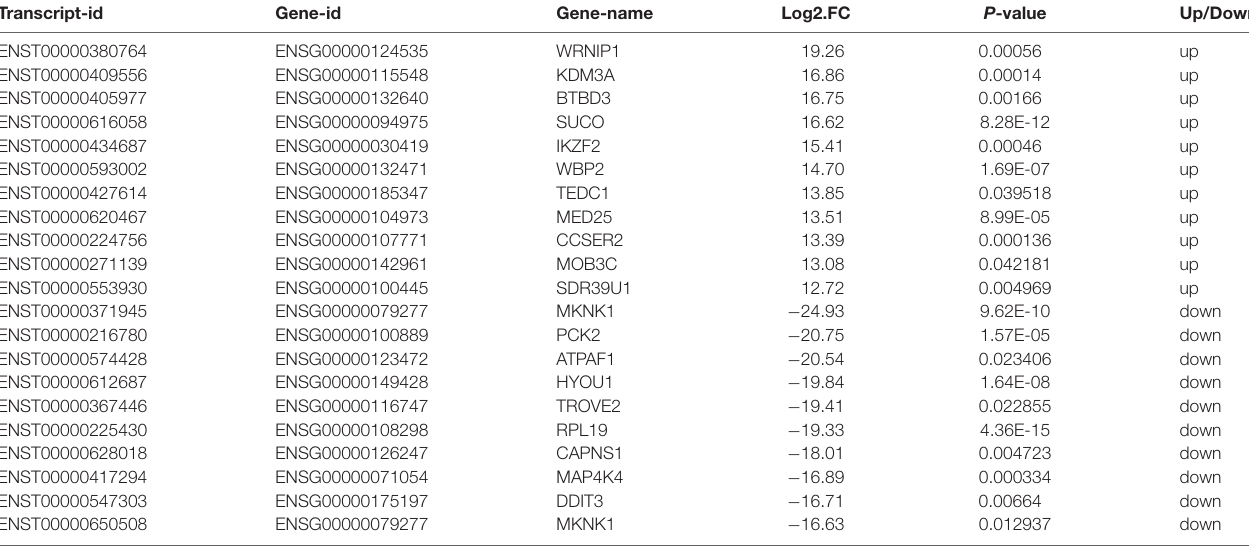
TABLE 4 | Top 10 upregulated and downregulated mRNAs (patients with AIS vs. healthy controls). Transcript-id